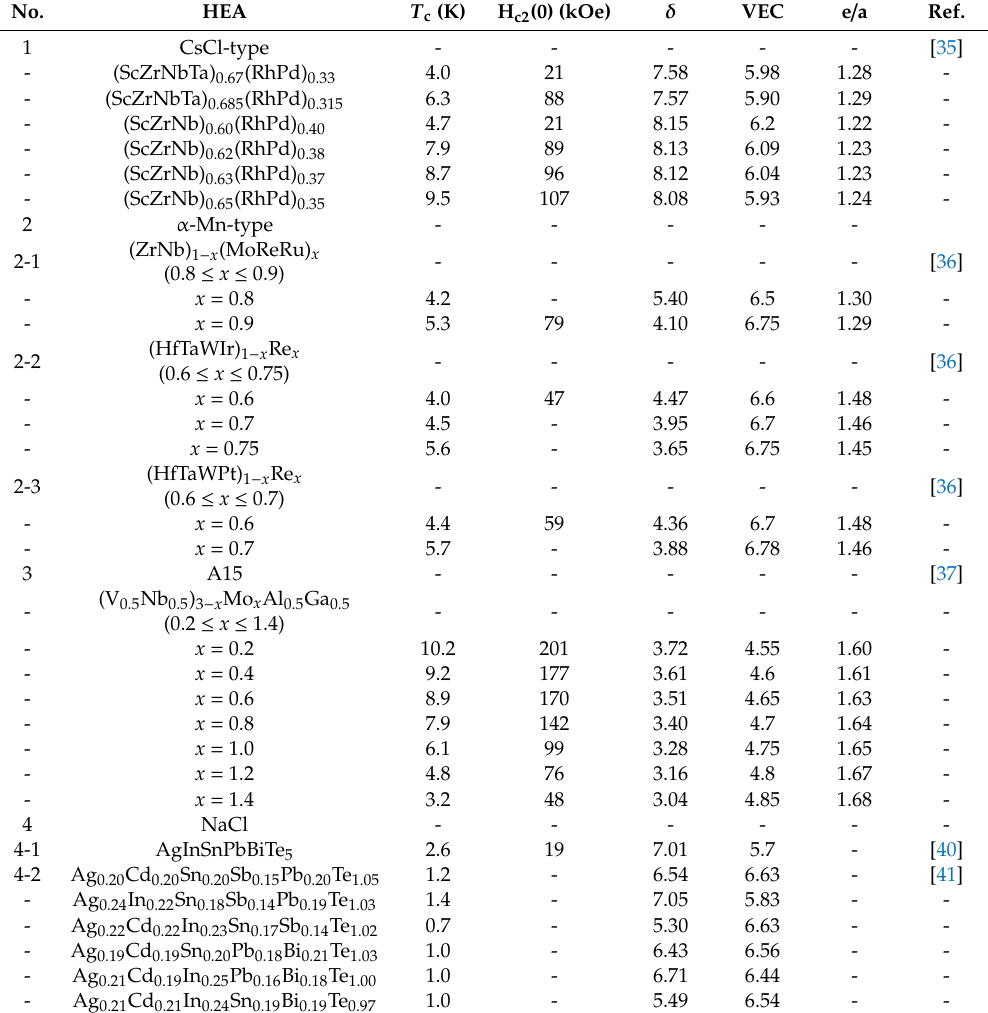
Table 4. Superconducting properties, δ , VEC and e/a of multisite HEA superconductors. T c and H c2 (0) data are from the references listed in the table.